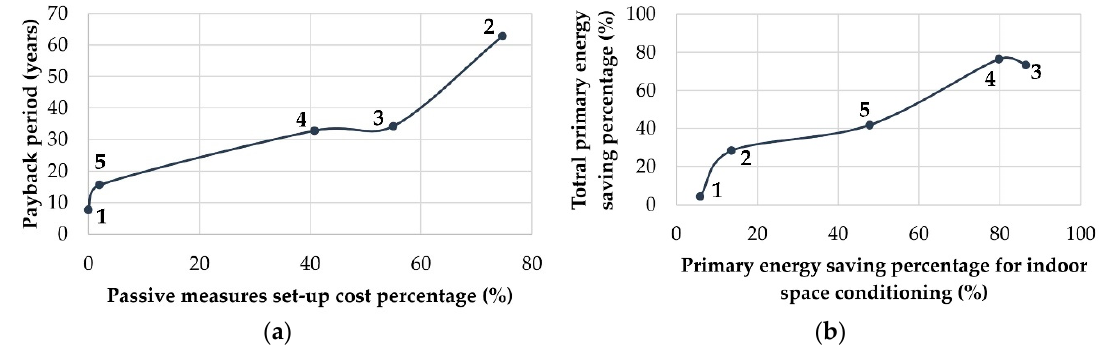
Figure 15. ( a ) Fluctuation of the total payback period of the proposed measures versus the passive measures set-up cost percentage over the total investments. ( b ) Fluctuation of the total primary energy saving percentage versus the primary energy saving percentage for indoor space conditioning.